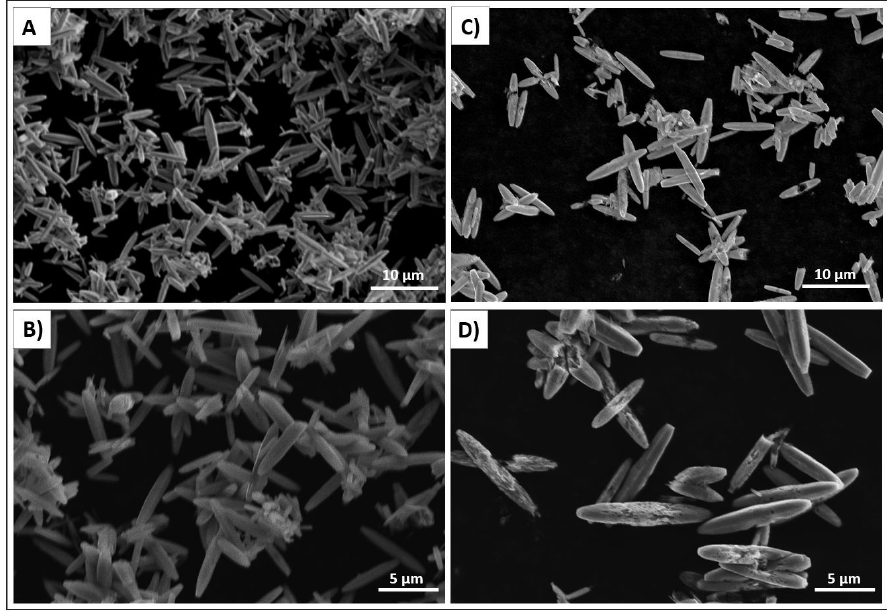
Figure 2. Scanning electron microscope images of ZnO (A) and (B) and Cu-ZnO microcrystals (C) and (D).